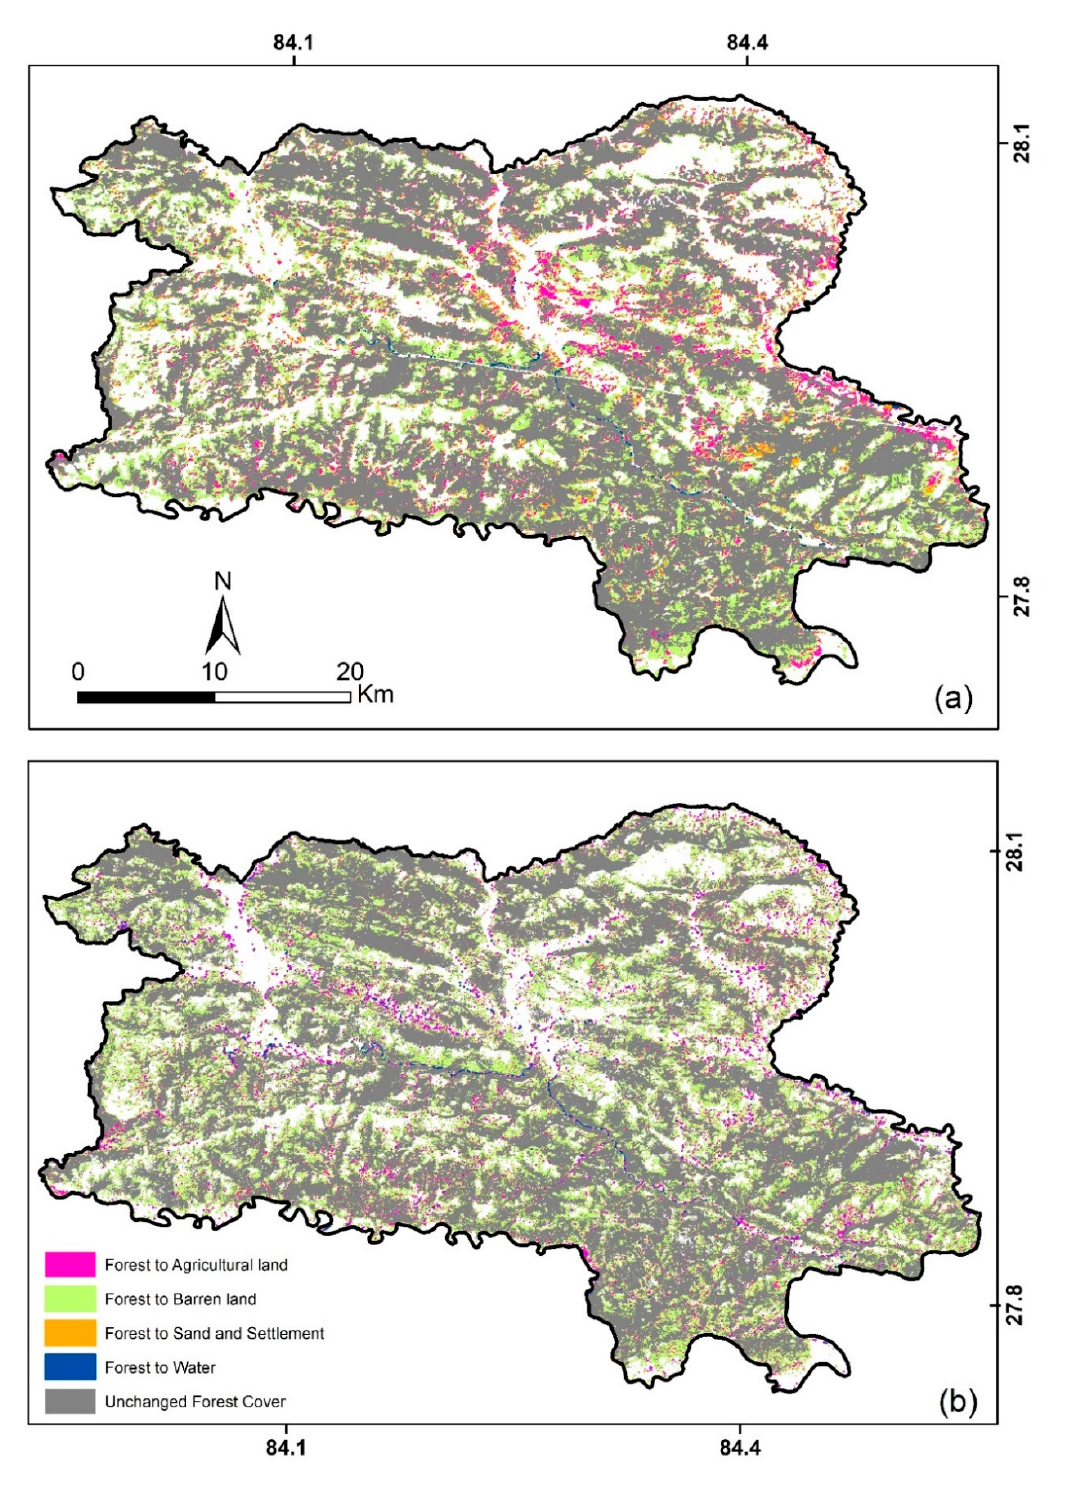
Figure 6. ( a ) Forest reduction in the study area from 1976–1991 and ( b ) 1991–2015.